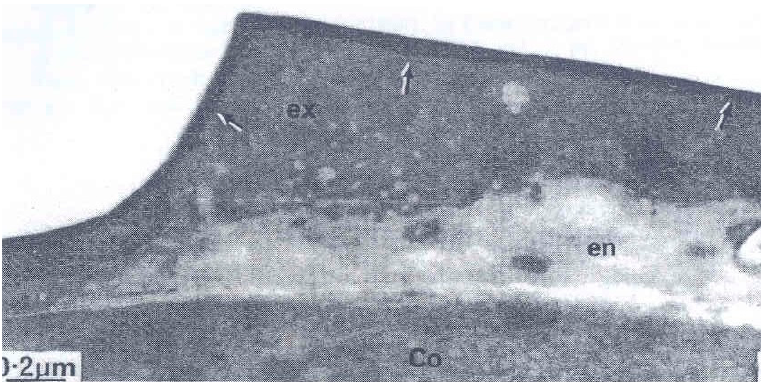
Figure 5. A cuticle cell of a wool fibre with almost complete consolidation of the exocuticle (ex) and the denser A-layer at the surface (arrows). From reference [4].